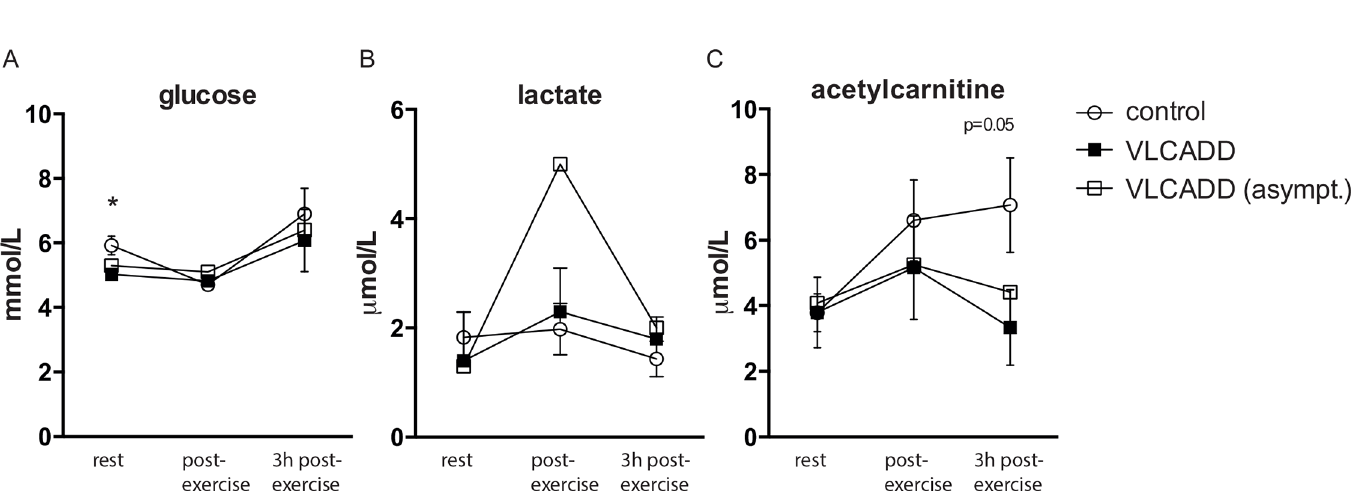
Fig 2. (A) Glucose, (B) lactate and(C) acetylcarnitine at t = 0 (rest), t = 1 (directly after exercise) and t = 2 (3 hours after exercise) in symptomatic VLCADD patients and controls. Error bars indicate mean ± SEM, * P < 0.05. doi:10.1371/journal.pone.0147818.g002 PLOS ONE | DOI:10.1371/journal.pone.0147818 February 16,